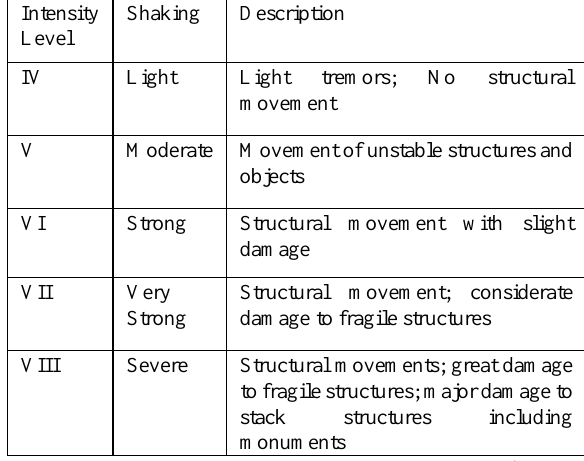
Table 4-1: Adapted Modified Mercalli Intensity Scale (USGS,